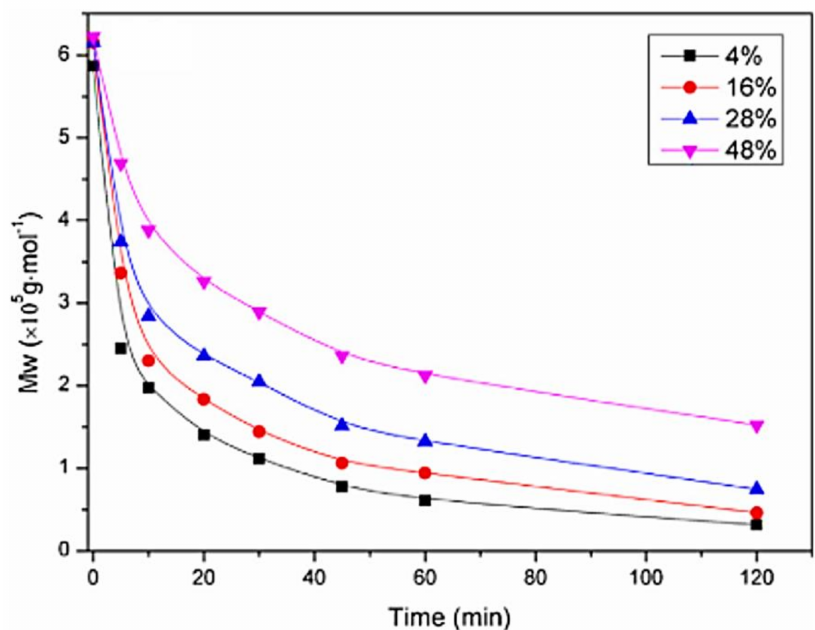
Figure 7. Depolymerization kinetics specifying nitrous deamination reaction duration for 4 different DA% chitosan with the same parent molar mass. Reprinted with permission from ref. [53]. Copyright 2015 Carbohydr.